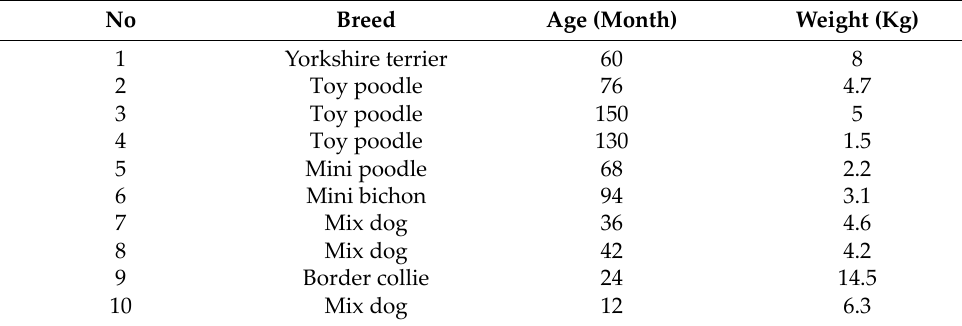
Table 3. Basic experimental subject information.